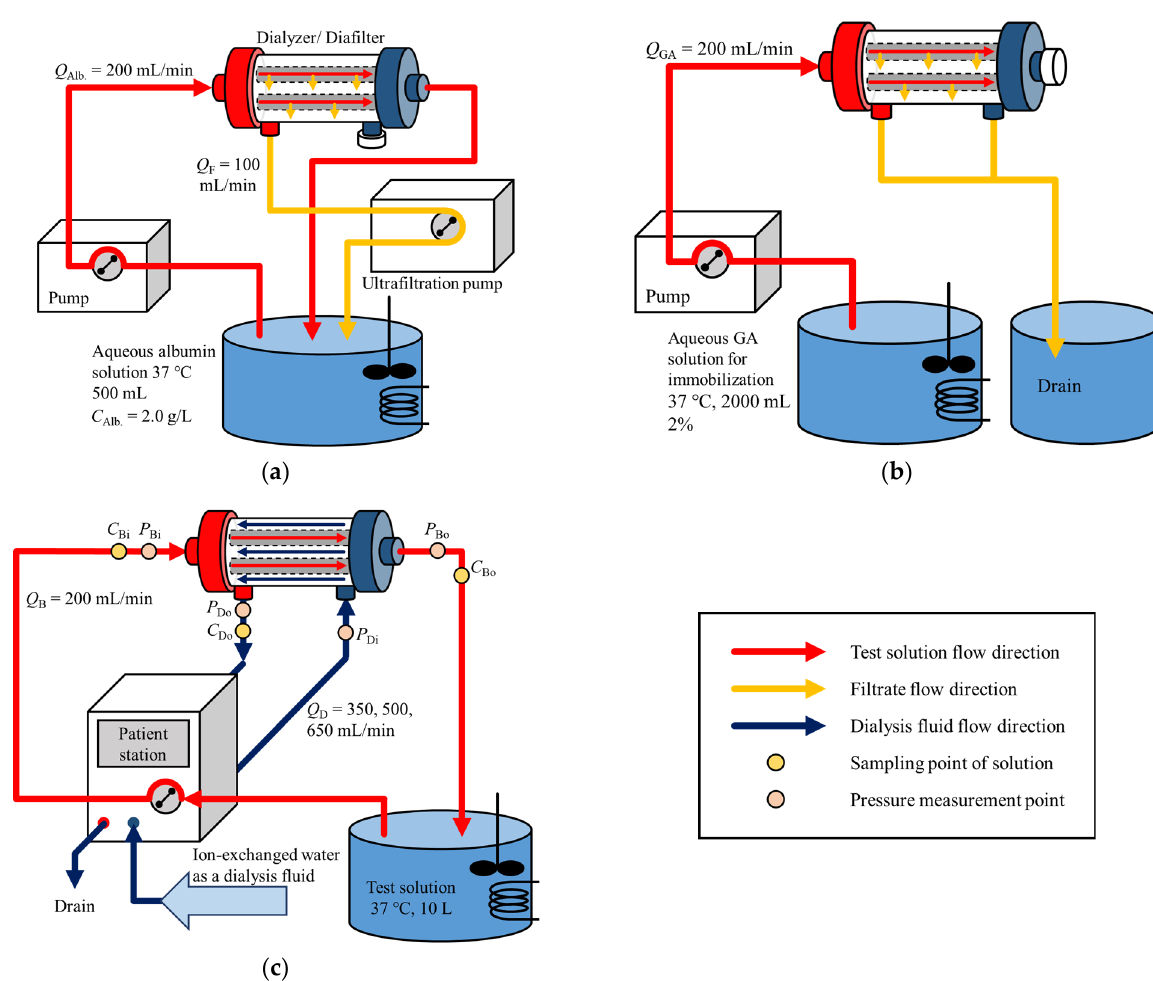
Figure 1. Test circuit for ( a ) albumin adsorption, ( b ) immobilization by glutaraldehyde, and ( c ) measurement of solute clearances.